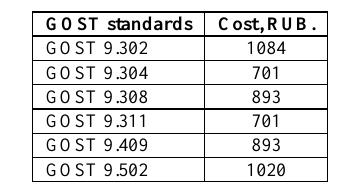
Table 3. Selective data on corrosion control inter-state